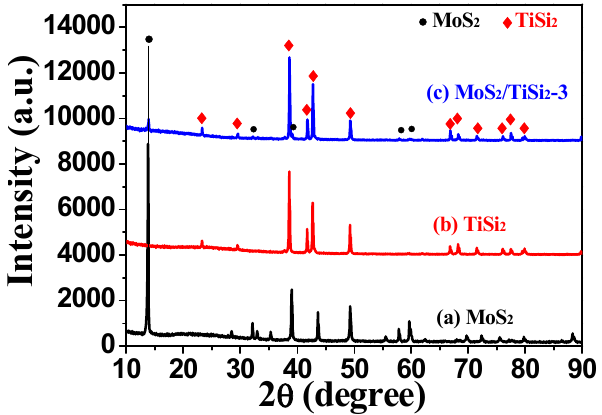
Figure 1. XRD patterns of the MoS 2 ( a ), TiSi 2 ( b ), and MoS 2 /TiSi 2 -3 ( c ).